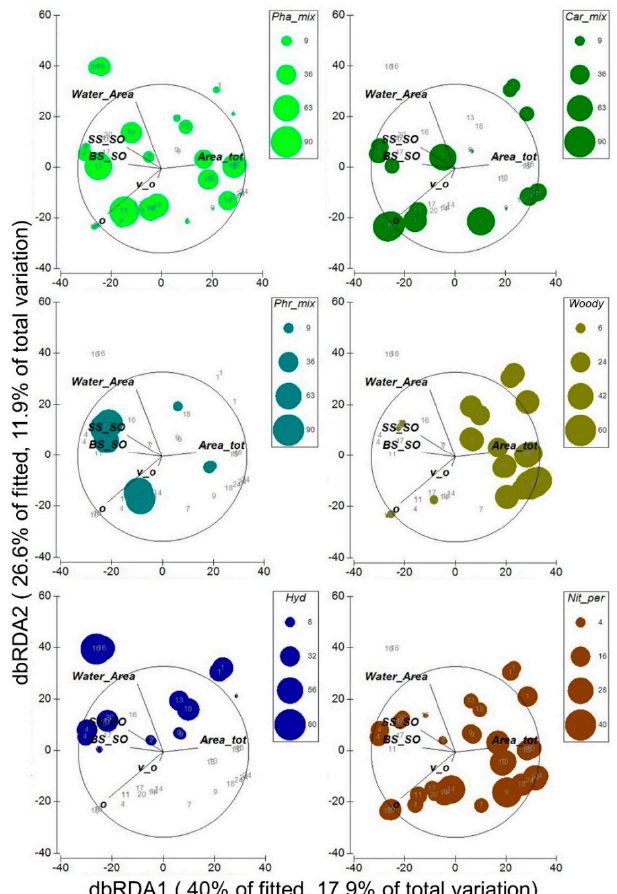
Figure 6. Bubble plots for each of the four dominant groups Phalaris (Pha_mix), Carex (Car_mix), Phragmites (Phr_mix)-mix and woody plants (woody) and the two most contrasting groups hy- drophytes (Hyd) and nitrophilous perennials (Nit_per) with regard to water area on the basis of the dbRDA ordination (see Figure 5). For abbreviation of environmental variables see Table